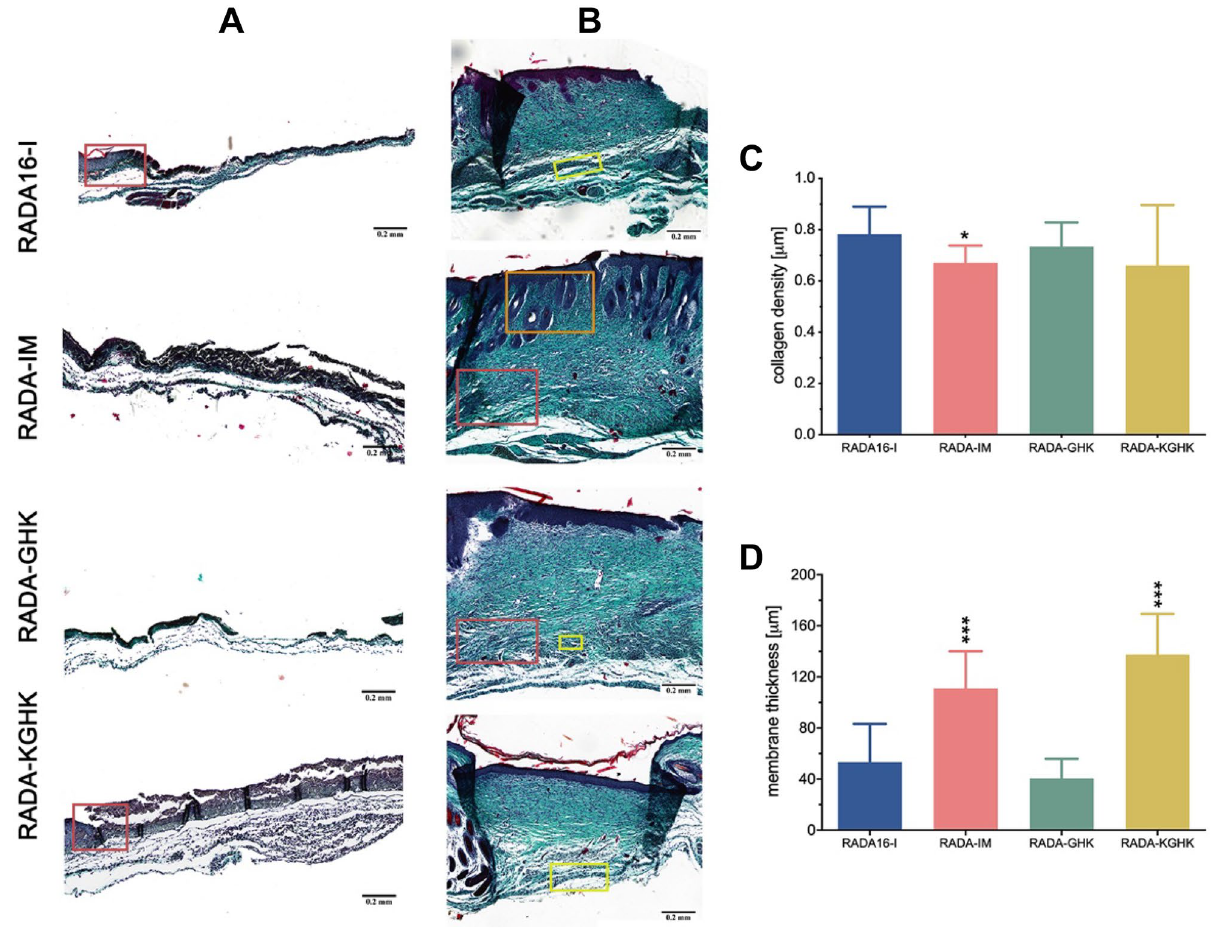
Figure 15. Images of dorsal skin samples stained with Masson’s trichrome stain ( A ), ( B ). ( A ) Samples collected on day 4 after injury show significant differences in tissue thickness, with a membrane-like structure (epithelium) covering the wound and keratinocytes visible on the edge of the peptide-treated wounds (brown square). ( B ) Skin samples of tissue treated with RADA16-I, RADA-GHK or RADA-KGHK harvested on day 18 show significant differences in tissue architecture to skin stimulated with RADA-IM peptide, where more hair follicles could be observed. Hair follicles (orange square), muscle-like cells (red square) and nuclei-dense regions (yellow square) can be observed in the latter tissues. ( C ) Skin treated with RADA-IM shows statistically significant lower collagen density than the RADA16-I sample on day 18 post-injury. ( D ) Quantification of epithelium thickness on day 4 post-injury shows that wounds treated with peptide RADA-IM and RADA- KGHK hybrids have significantly thicker epithelium than those of the RADA16-I group. Statistical significance was determined with the Mann–Whitney U test; one (*), two (**), or three asterisks (***) indicate p < 0 .05, p < 0 .01, or p < 0 .001,